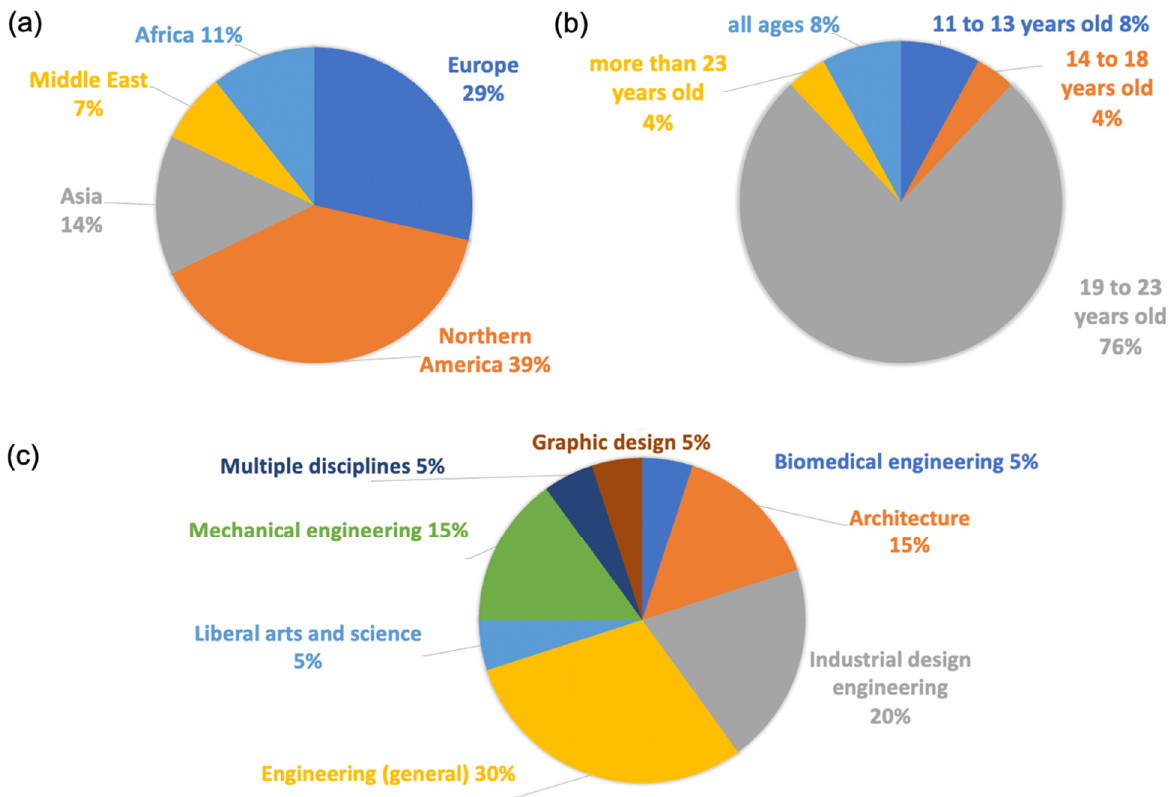
Figure 2. Percentages of published studies classi fi ed by ( a ) region, ( b ) age group, and ( c ) major. Despite the diversity of the students’ and module participants’ backgrounds, ages, and cultures, the outcomes of the studies did not show any signi fi cant di ff erences. Most papers reported similar positive outcomes, and the remaining challenges are reported in Table 1. The signi fi cant challenge that has been reported many times is the di ffi culty in